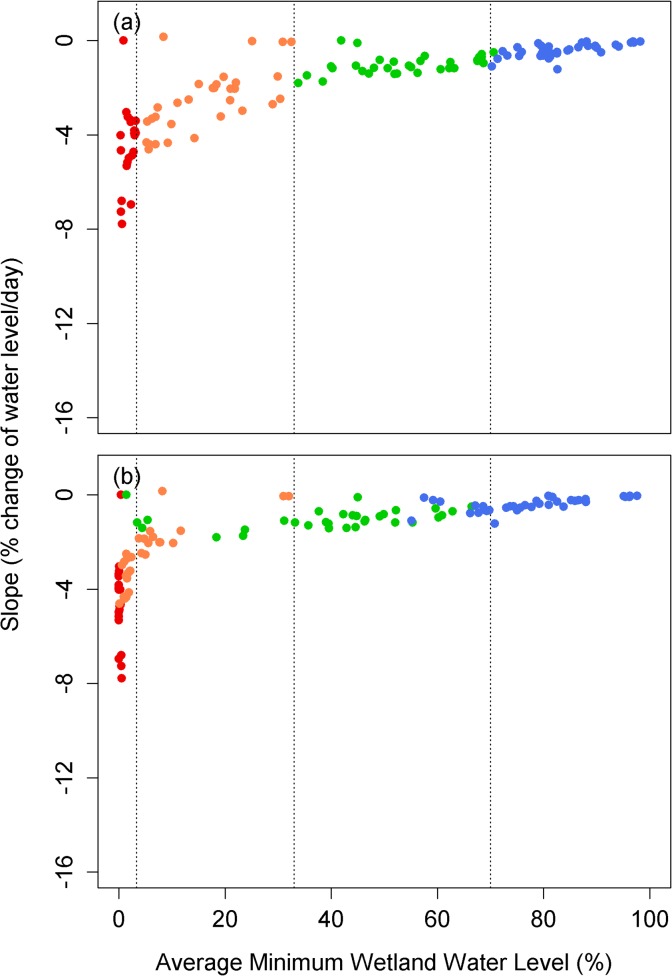
Scatterplots showing the slope of wetland drying versus the average of annual minimum a) for historical runs and b) for the 2080s.Reds are ephemeral hydroperiod wetlands, oranges are intermediate hydroperiod wetland, greens are perennial wetlands and blues are permanent wetlands.